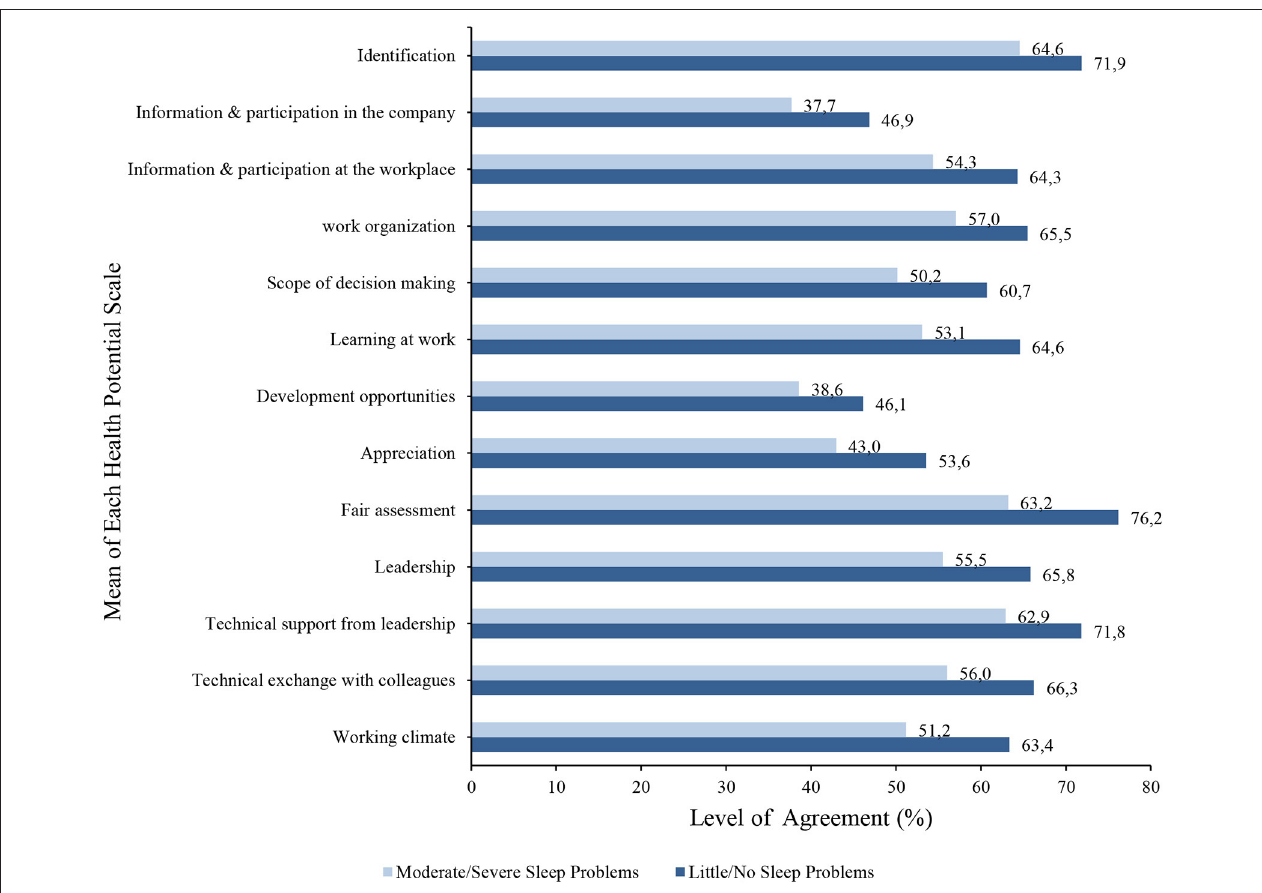
FIGURE 3 | A bar graph to show the mean level of agreement for each health potential (scales that refer to the positive effects on our well-being) in both good and poor sleepers.